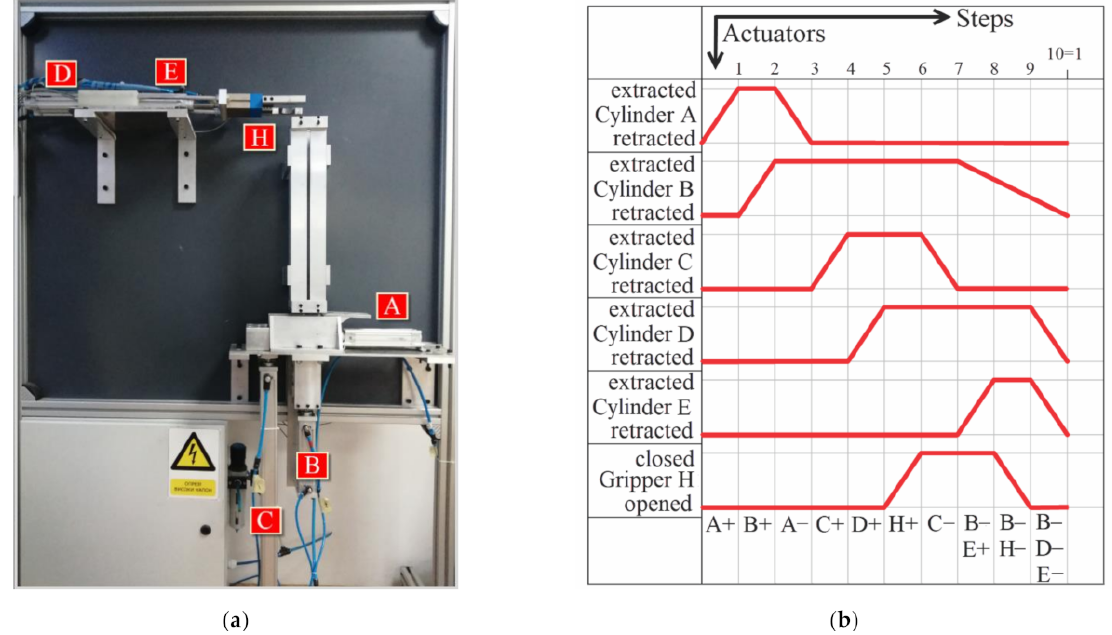
Figure 1. Pneumatic circular manipulator ( a ) hardware realization. Reproduced from [5], IJOE, 2018. ( b ) travel-step